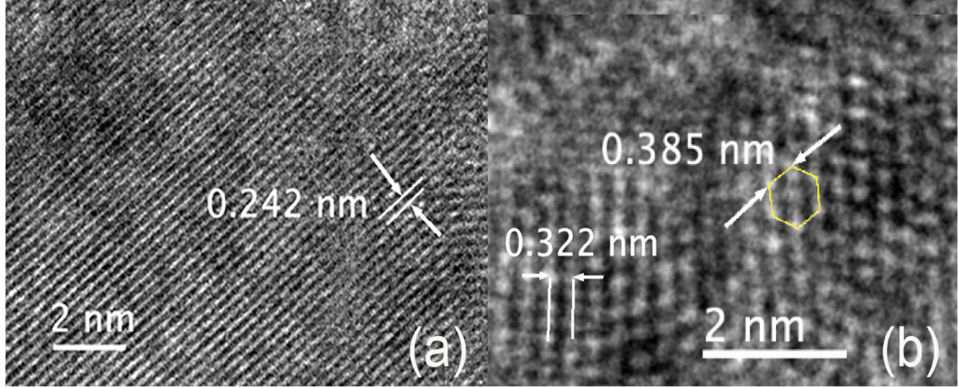
Figure 6. TEM image of the nanoceria obtained from the dissolution of S5NBCe glass with ( a ) the (100) plane of cubic CeO 2, ( b ) the (111) pane of cubic CeO 2 .